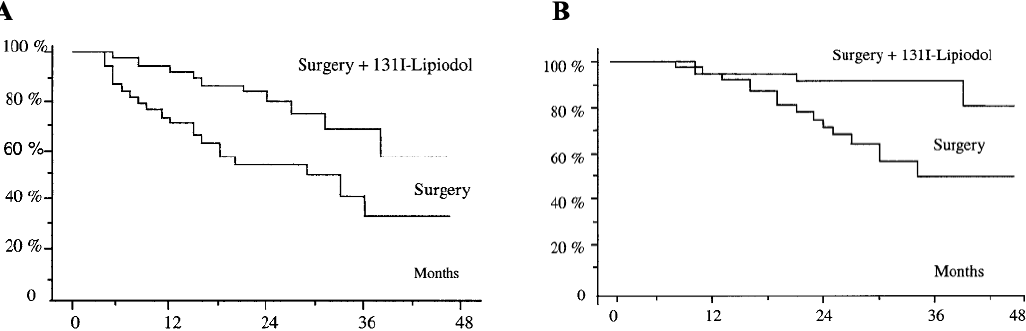
Figure 1. Adjuvant intra-arterial injection of iodine-131-labeled lipiodol after resection of HCC. ( A ) Disease-free survival of patients in the 2 treatment groups ( p < 0.02). ( B ) Overall survival of patients in the 2 treatment groups ( p < 0.02). Adapted with permission from [32].